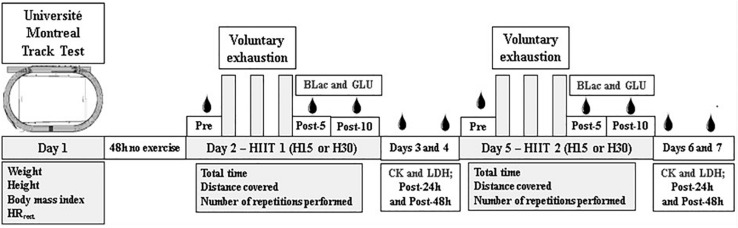
Description of the experimental study procedure. HRrest: Heart Rate Rest; BLac: Blood Lactate; GLU: Blood Glucose; CK: Creatine Kinase; LDH: Lactate dehydrogenase; H15: Work-recovery duration 15 s (15:15); H30: Work-recovery duration 30 s (30:30).